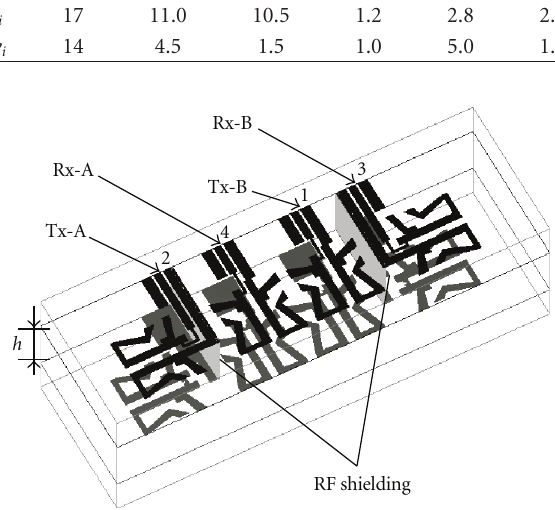
Figure 18: Four antennas in 2 × 2 MIMO configuration.